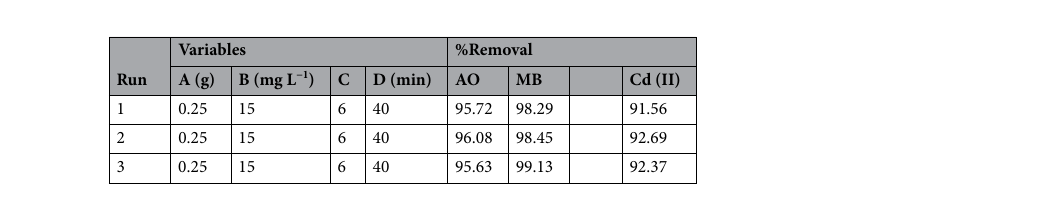
Table 4. Optimum conditions of removal of AO, MB, and Cd